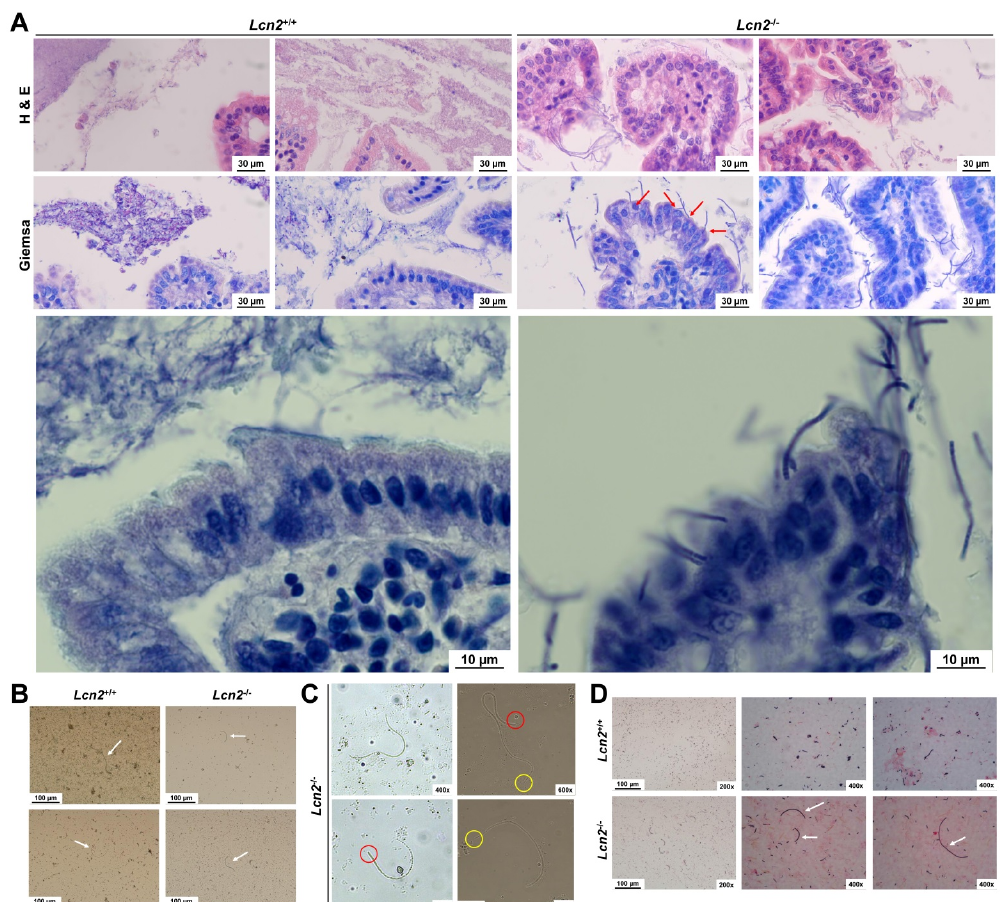
Figure 10. Detection of segmented filamentous bacteria in the distal small intestine of wild type and Lcn2 -/- mice. ( A ) Paraffin-embedded tissue samples prepared from the small intestine of wild type and Lcn2 -/- mice were stained with hematoxylin & eosin (H & E), and Giemsa (each n = 4). Red arrows indicate the close relationship of segmented filamentous bacteria (SFB) and epithelial cells. Images taken at higher magnification (630×) are shown in the lower panels. ( B , C ) Smears of extracted small intestinal contents from wild type and Lcn2 -/- mice were mounted in DPX and used for microscopical analysis. White arrows indicate SFB ( B ). Red circles indicate the bold and yellow circles the fine segmented tip of SFB ( C ). ( D ) Smears of extracted small intestinal contents from wild type and Lcn2 -/- mice were prepared and stained according to the Gram procedure, mounted in DPX, and used for microscopy. White arrows indicate Gram-stained SFB. Since the above-mentioned criteria resembled those of SFB, we performed PCR with DNA extracted from the distant ileal content (Figure 11A). Those PCRs (i) validated the extraction of bacterial DNA and (ii) showed the presence and different degrees of colo- nization of the distant ileum of Lcn2 null mice with SFB compared to wild type mice (Figure 11A). In this analysis, specific detection of SFB 16S rDNA was performed using